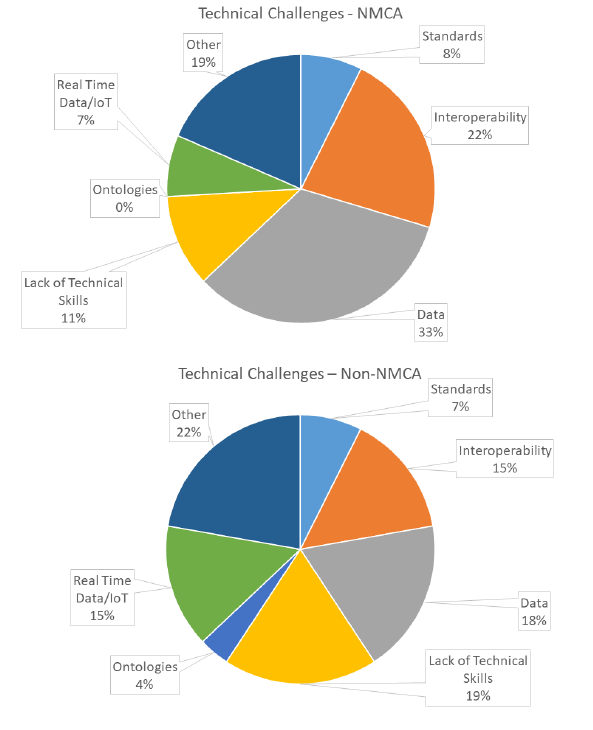
Figure 4: Technical